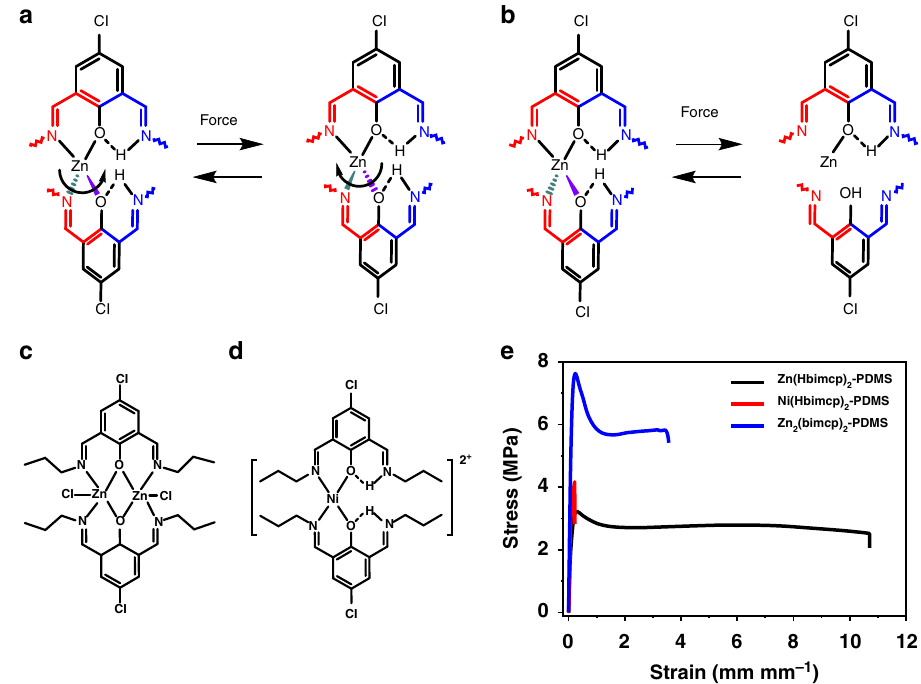
Fig. 3 Control experiments for mechanism study. a , b Two energy dissipation process for [Zn(Hbimcp) 2 ] 2 + . c The molecular structure of [Zn 2 (bimcp) 2 Cl 2 ]. d The molecular structure of [Ni(Hbimcp) 2 ] 2 + . e Comparison of stress – strain curves for Zn(Hbimcp) 2 -PDMS , Ni(Hbimcp) 2 -PDMS polymer, and Zn 2 (bimcp) 2